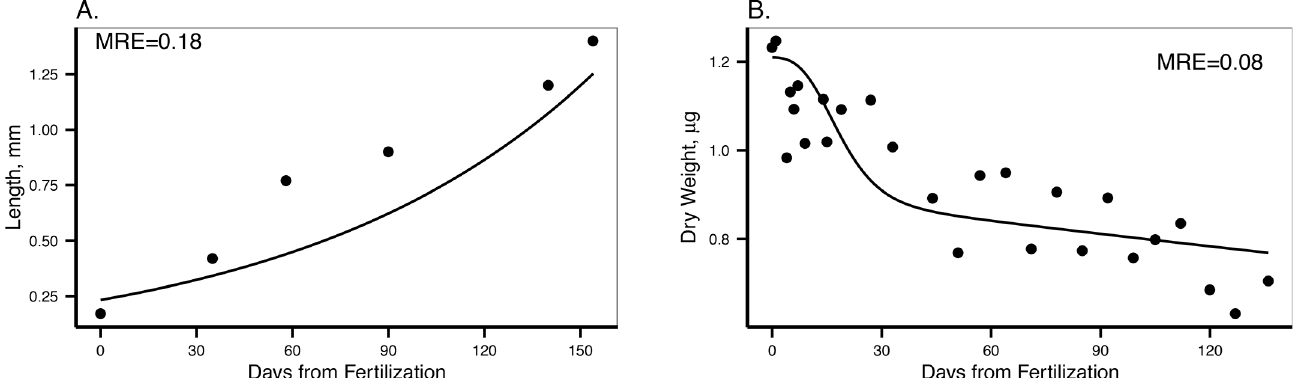
Fig 6. DEB model output with data on pre-metamorphic individuals used for parameter estimation. A. Larval growth in length according to age. Dots are observations in the laboratory [29]. Food was available in excess and the animals fed once they were able to do so. B. Loss of dry weight from fertilization, data from [37]. In this case there was no food available during the whole experiment. MRE is the mean absolute relative